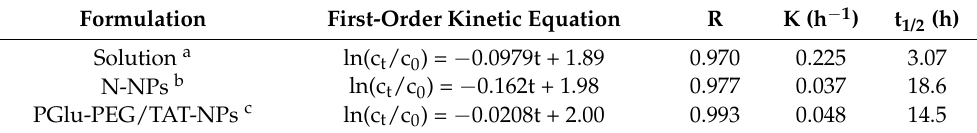
Figure 4. Degradation curves of DSF in solution as well as N-NPs and PGlu-PEG/TAT-NPs in rat plasma ( n = 3). Solution, DSF dissolved in saline with a low content of Cremophor EL/ethanol; N-NPs, DSF-loaded naked nanoparticles; PGlu-PEG/TAT-NPs, DSF-loaded shell/core composite nanoparticles. Table 2. Degradation kinetic equations and parameters of DSF in rat